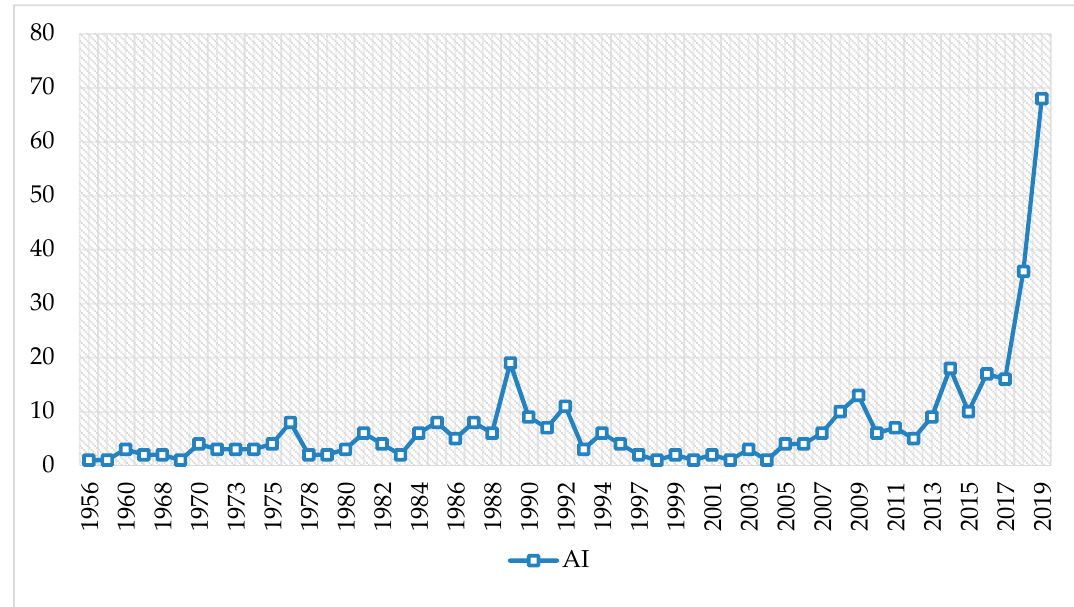
Figure 2. Evolution of scientific production.